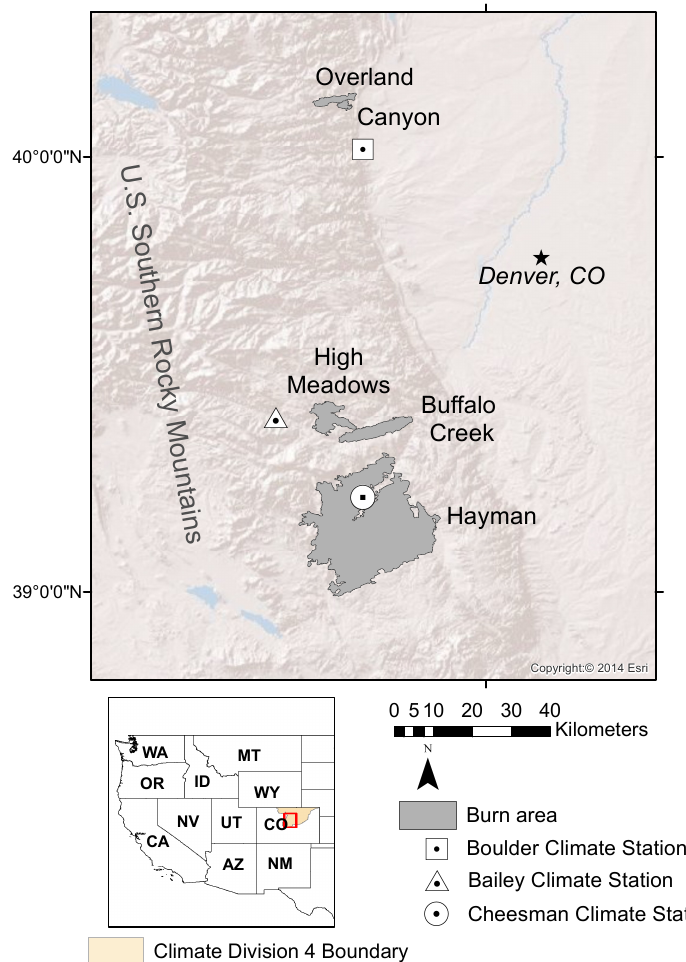
Figure 1. Locations of the five recently burned areas included in this study. All sites are within the lower montane zone of the Colorado Front Range, along the eastern edge of the U.S. Southern Rocky Mountains. All sites are characterized by dry ponderosa pine forests and are at elevations ranging between 1950 and 2230 m. The Boulder, Bailey, and Cheesman Cooperative Observer Program (COOP) climate stations and the boundary for the National Climatic Data Center (NCDC) Climate Division 4 for Colorado are also